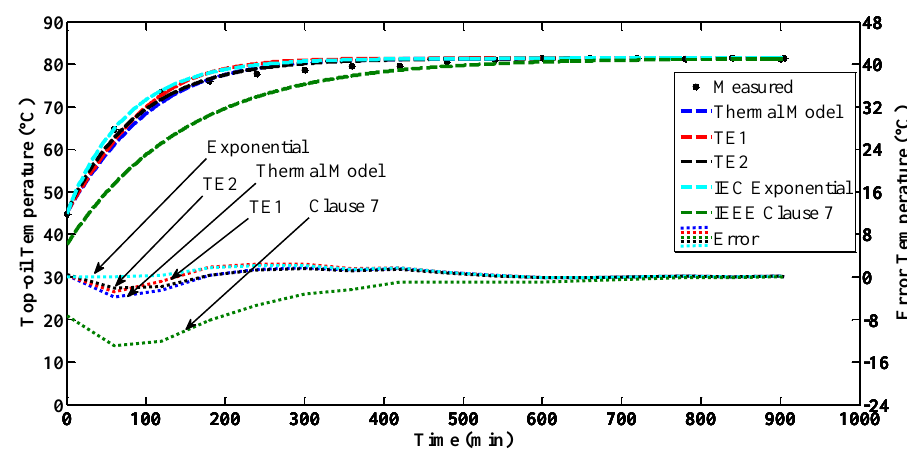
Figure 8. TOT based on different thermal models for TX2.